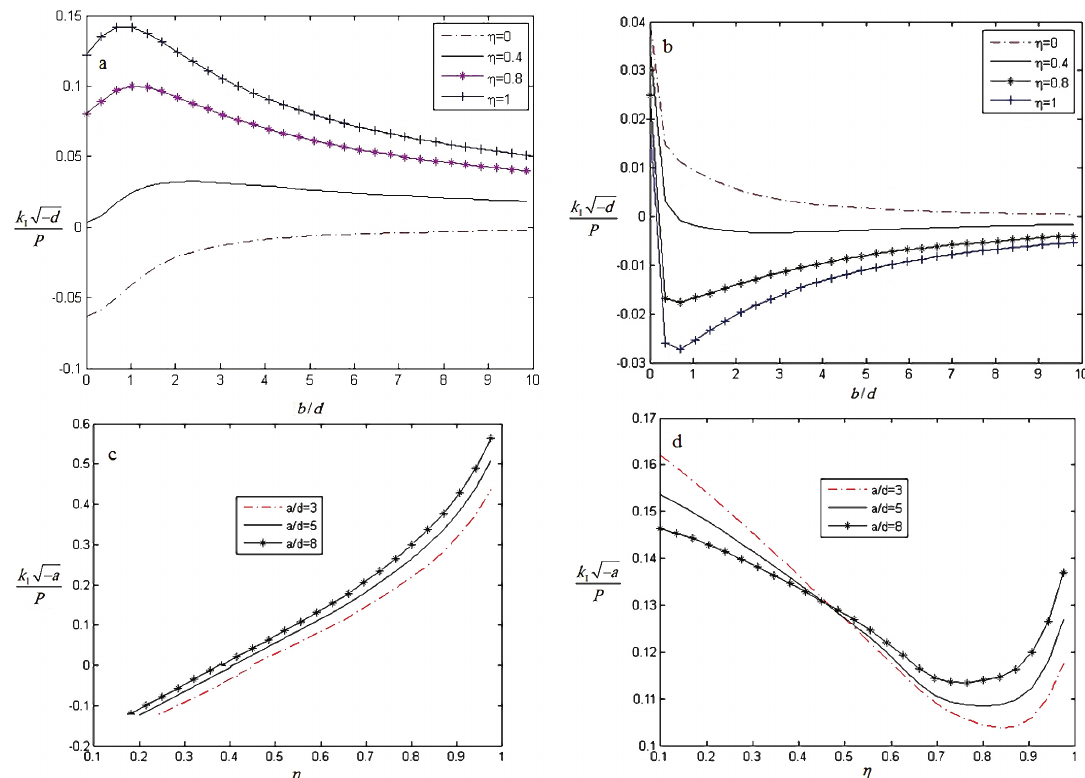
Figure 7. Normalized stress intensity factor distributions generated by considering a flat punch: (a) mod І for (a-b)/d=10, υ=0.28; (b) mod П for (a-b)/d=10, υ=0.28; (c) mod І for b=0, υ=0.28; (d) mod П for b=0,